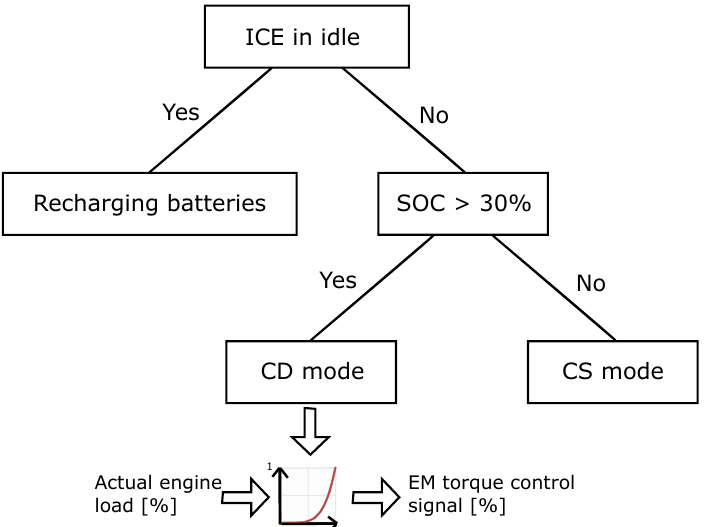
Figure 13. Parallel hybrid and electro-hydraulic hybrid control